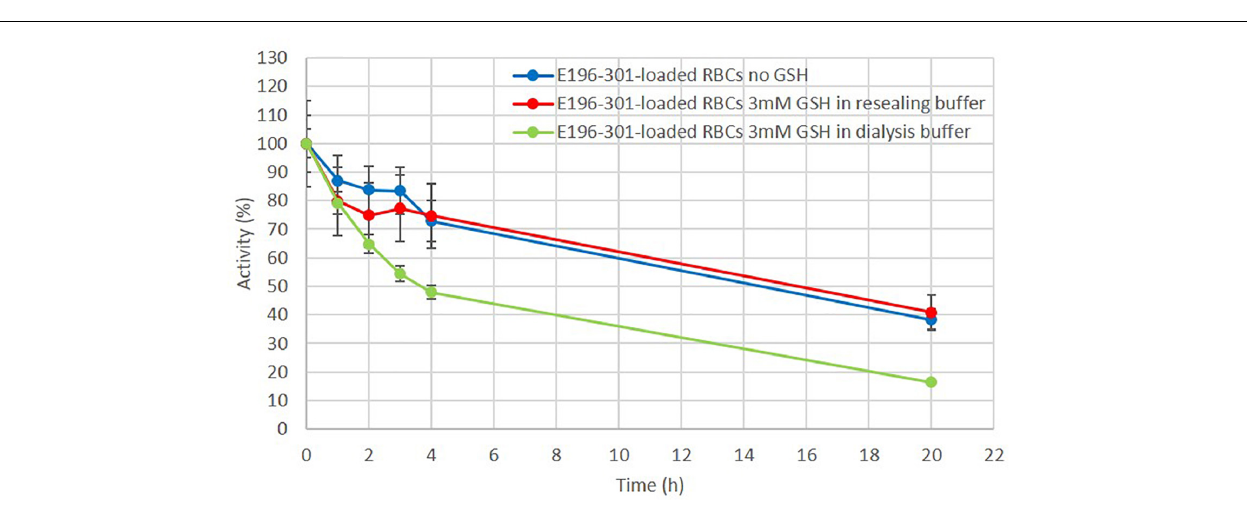
FIGURE 6 | Effect of reduced glutathione (GSH) in E196-301 stability once encapsulated in red blood cells (RBCs). In vitro stability of RBC-loaded E196-301 at 37 ◦ C in PBS, pH 7.2. RBC-loaded enzyme was tested at 15 ± 2 IU/ml RBCs. All experiments were in duplicate that agree within 7.5%. Results are mean ± SD of three different